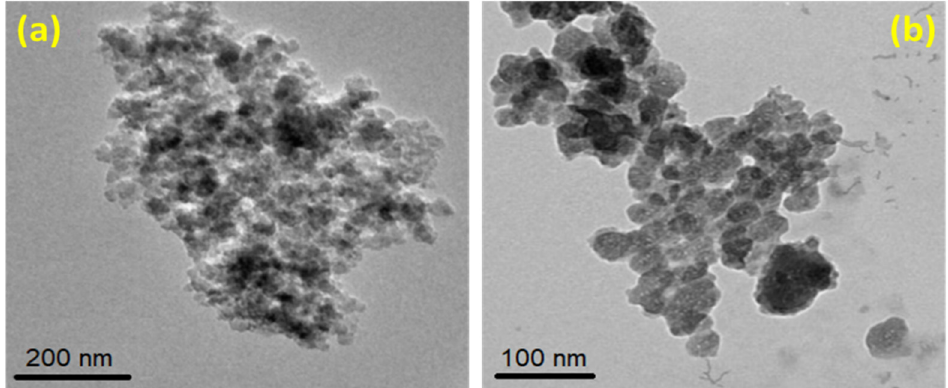
Figure 5. TEM images of SiO 2 NPs depict the particle sizes at different scales: ( a ) 200 nm and ( b ) 100 nm, respectively.